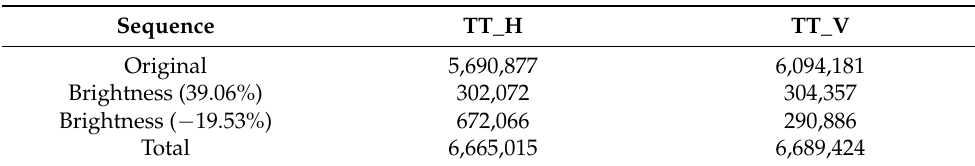
Table 2. The number of training samples for horizontal ternary tree (TT_H) and vertical ternary tree (TT_V) of sequences.